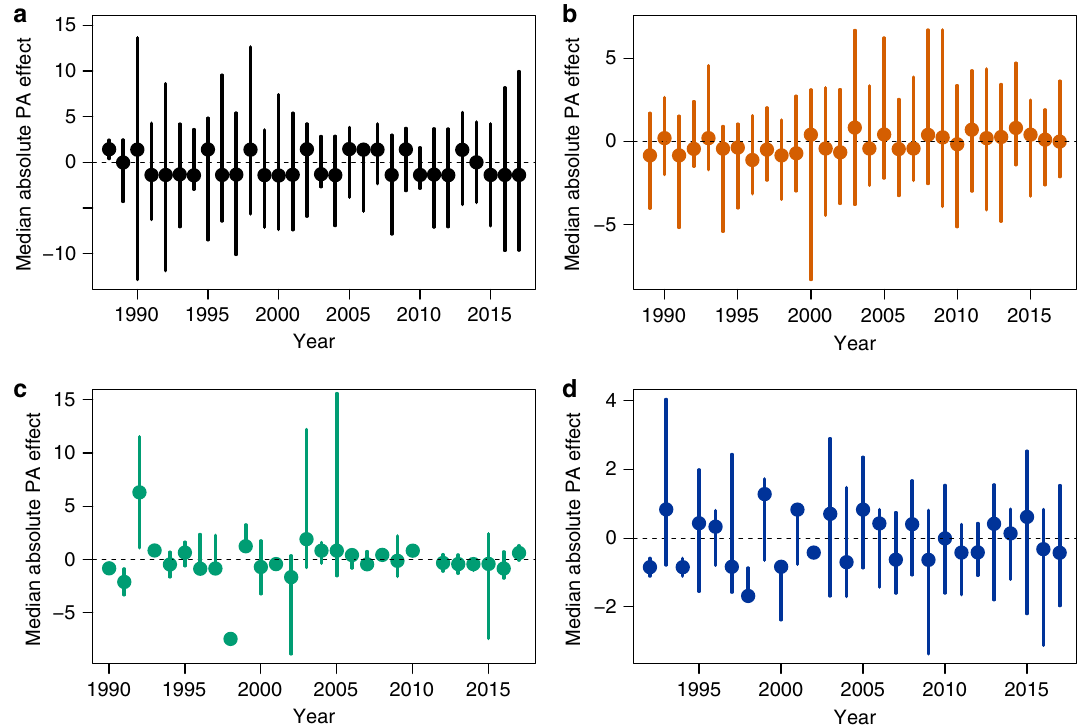
Fig. 2 PA effectiveness estimates derived from matching analyses. Mean annual absolute effect of the Finnish PA network on ( a ) bear ( n = 209 paired sampling units), ( b ) lynx ( n = 207), ( c ) wolf ( n = 67) and ( d ) wolverine ( n = 75) densities during 1989 – 2017, using only matched protected and unprotected wildlife units. Colored dots and arrows represent median estimates and 95% con fi dence interval,